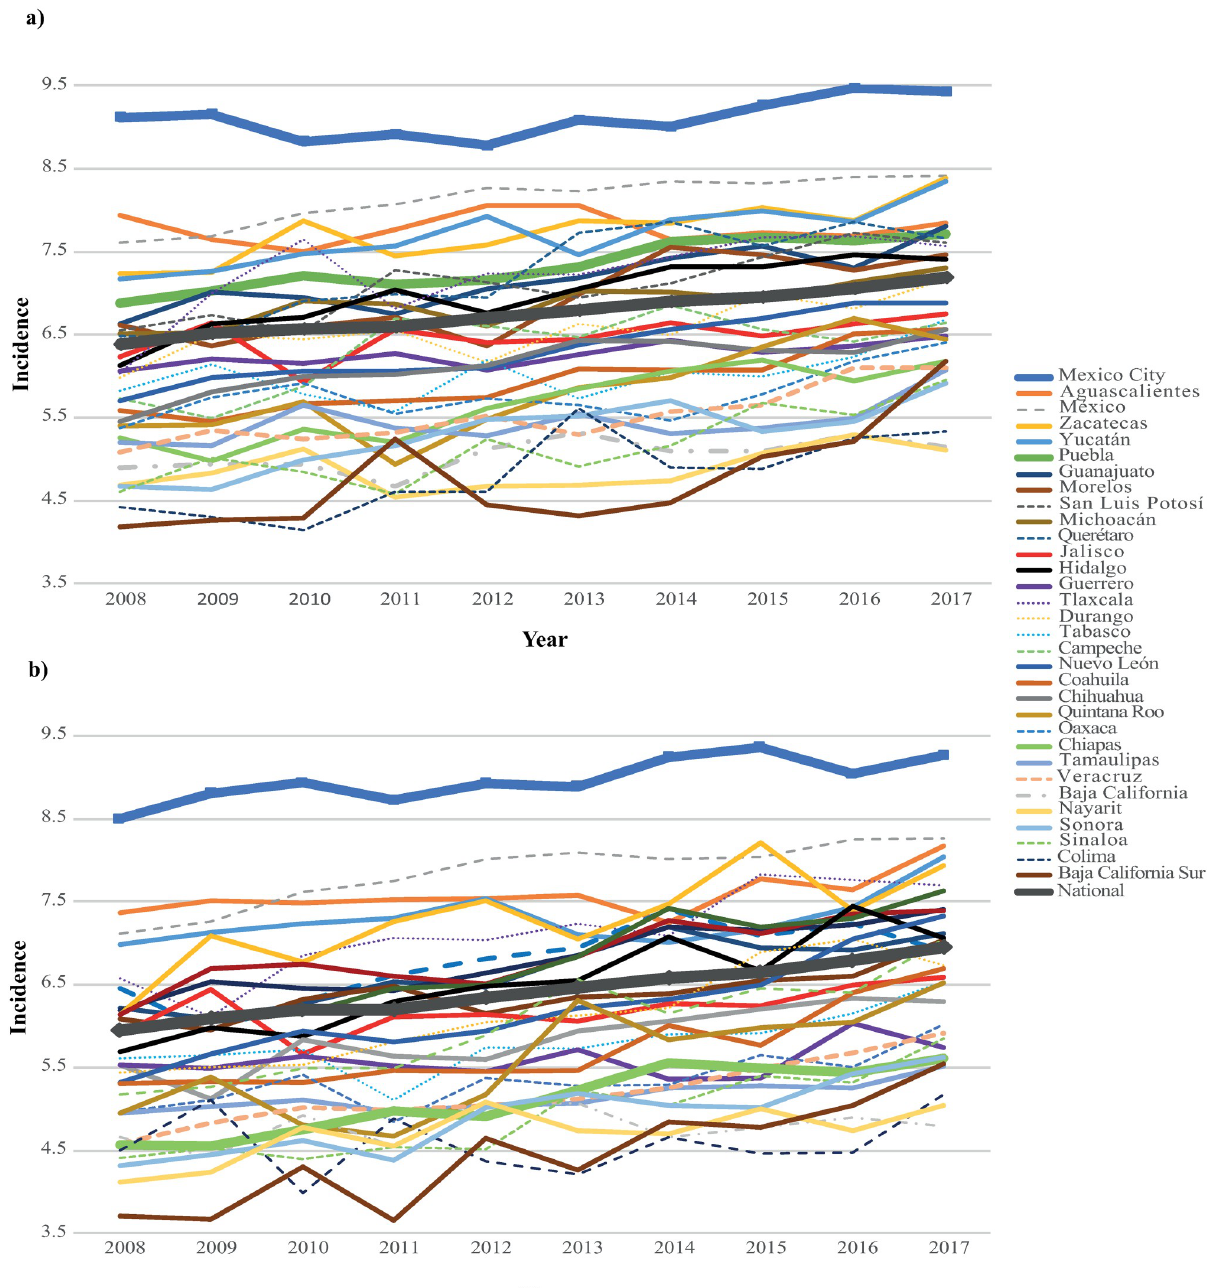
Fig 1. a. LBW incidence in males from 2008 to 2017. b. LBW incidence in females from 2008 to 2017. https://doi.org/10.1371/journal.pone.0256518.g001 Aguascalientes (ID 01) (7.93% and 7.37%, respectively), and Mexico State (ID 15) (7.60% and 7.12%, respectively); the fourth and fifth position in males were Zacatecas (ID 32) (7.24%) and Yucata´n (ID 31) (7.18%), whereas in females were Yucata´n (ID 31) (6.99%) and Tlaxcala (ID 29)(6.57%). In 2017, Mexico City (ID 09) represented the state with the highest incidence (9.43% and 9.26% in male and female, respectively), followed by Mexico State (ID 15) (8.42%